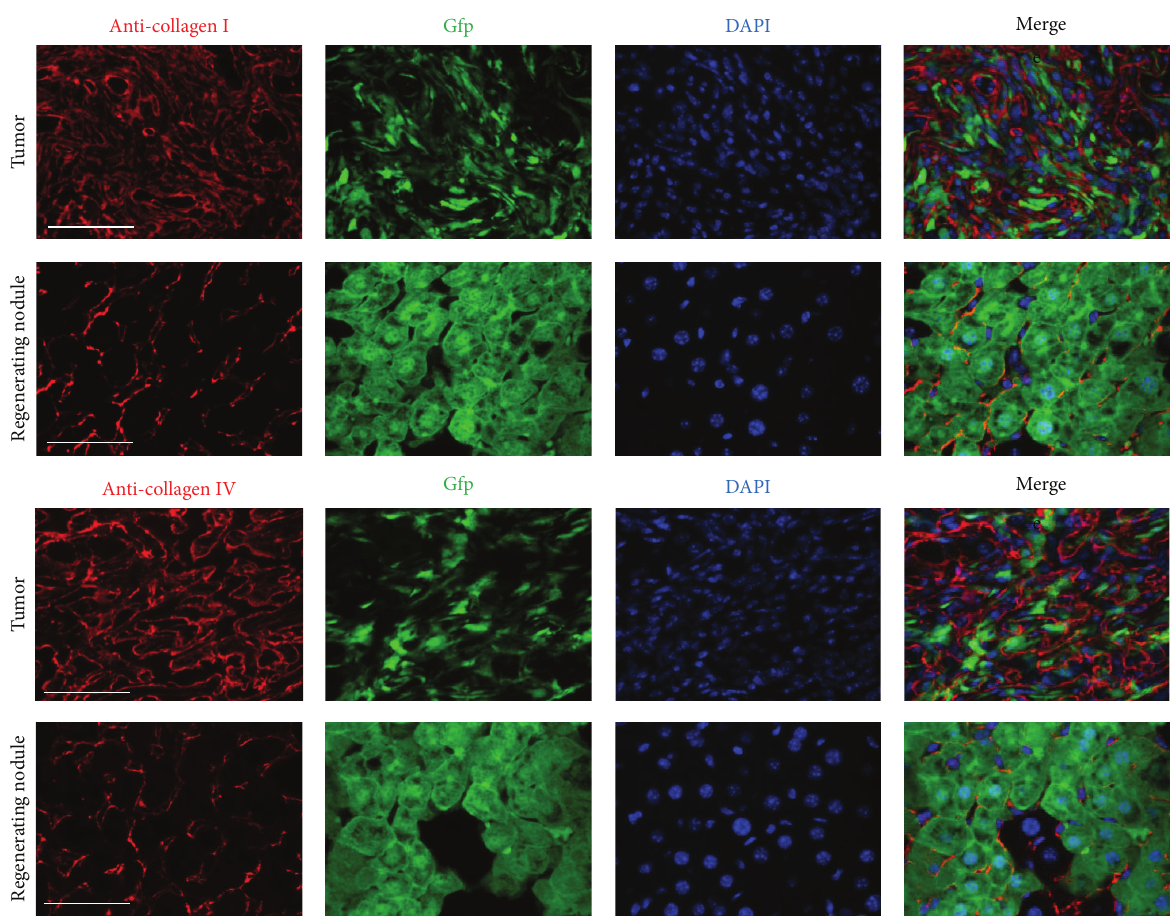
Figure 6: Comparison of ECM protein expression in regenerating nodules and liver tumors. Sections were stained with anti-collagen I and IV antibodies (red). Immunofluorescence was used to detect donor BMC-derived GFP (green). Markedly increased type I and IV collagen deposition was observed in the tumor area compared to that in regenerating liver nodules. Scale bar represents 30 𝜇 m.